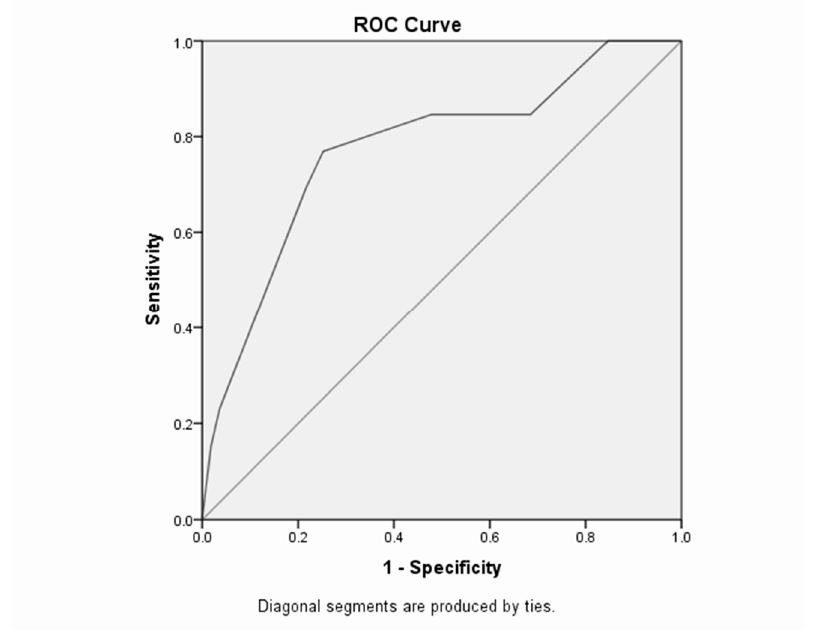
Figure 2. ROC Curve and Area for the Maternal Binary Logistic Regression Model.